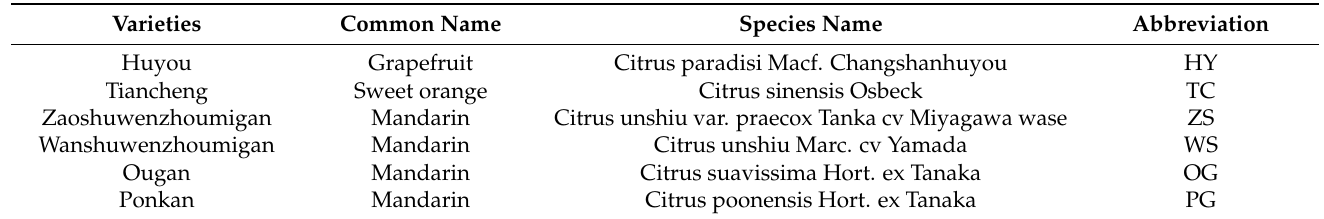
Table 4. Scientific classification of six citrus cultivars studied in this